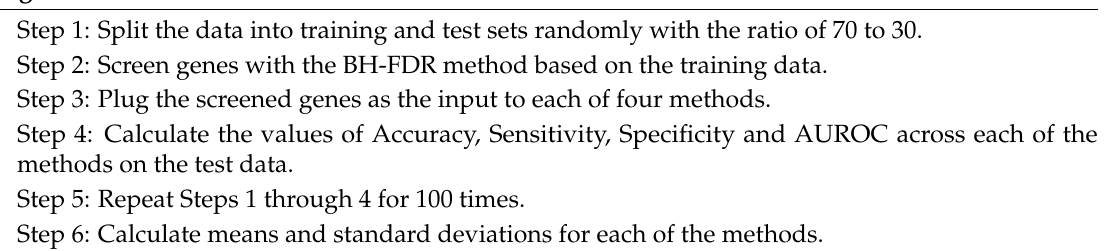
Algorithm 2 Calculation of mean with standard deviation on colon cancer data